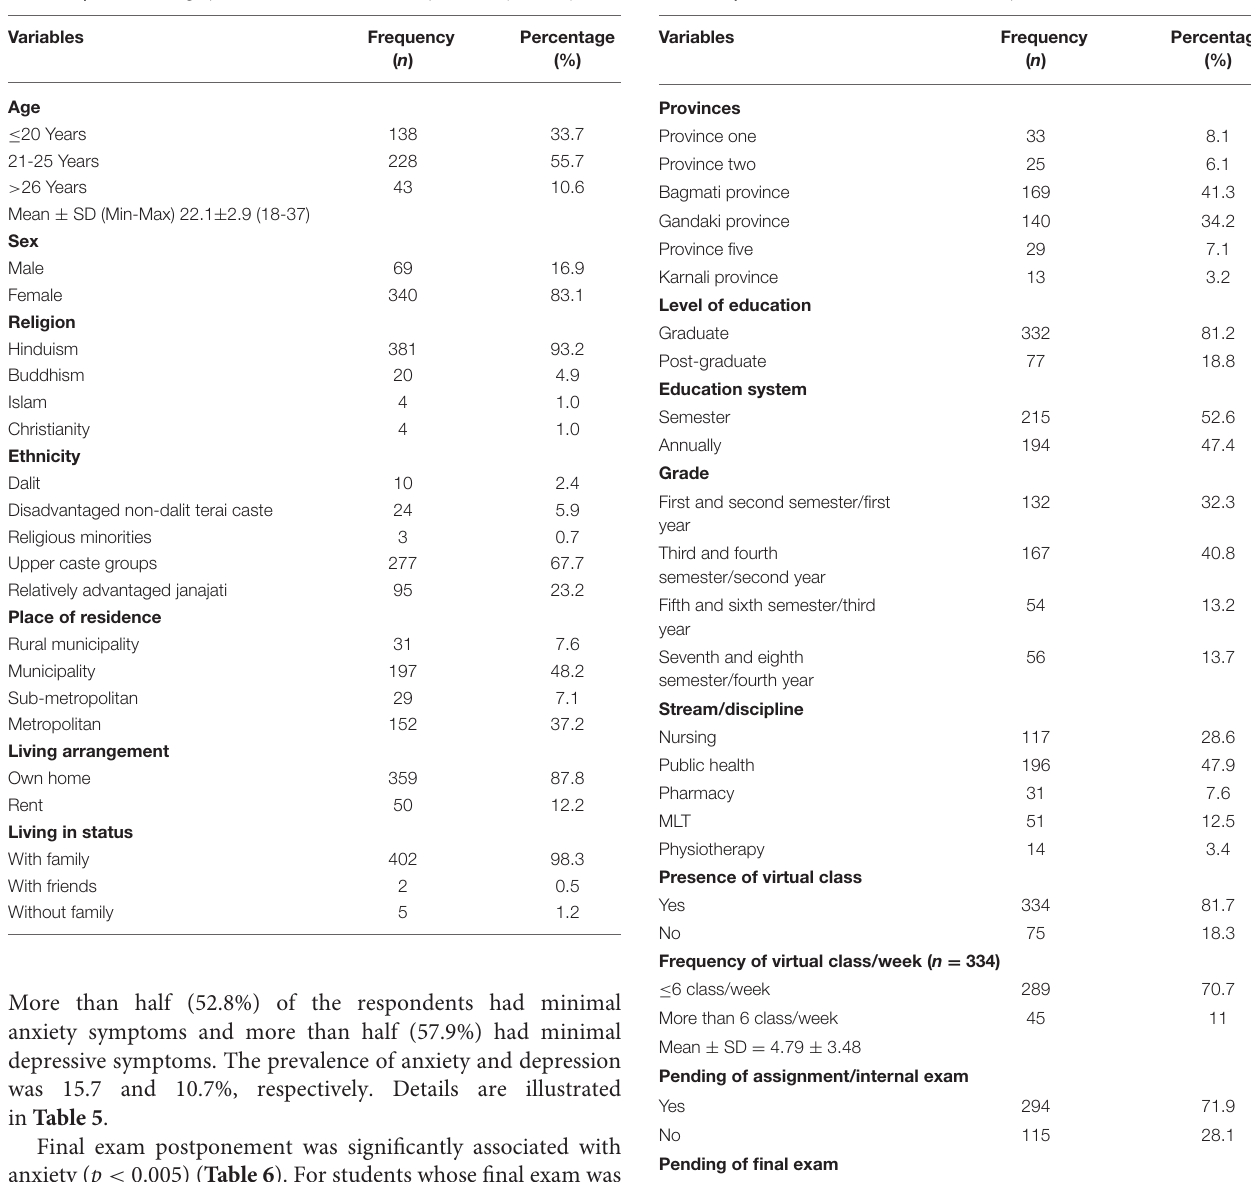
TABLE 1 | Socio-demographic characteristics of the respondents ( n = 409). TABLE 2 | Education-related information of